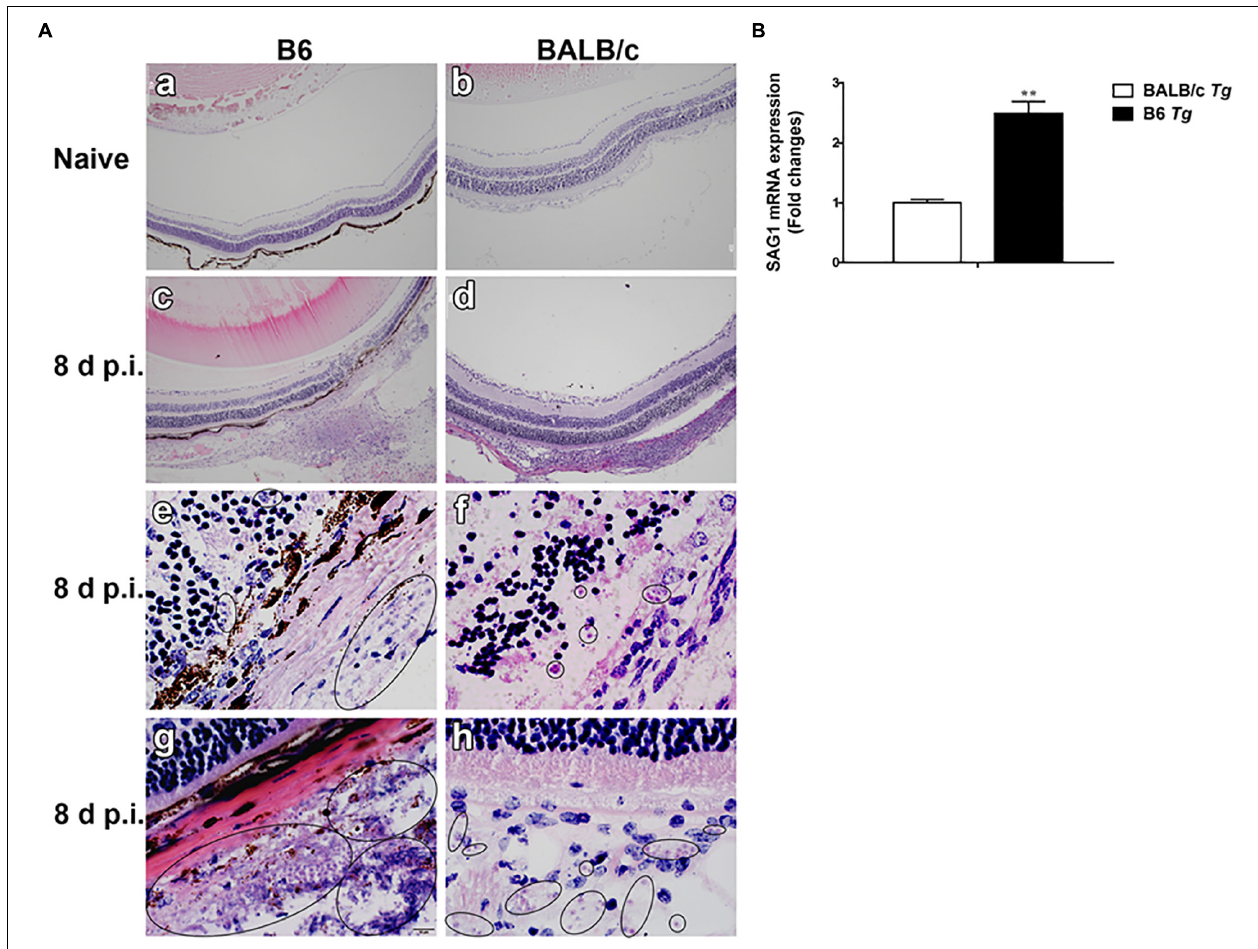
FIGURE 1 | Histological changes (A) and parasite burden (B) in the eyes of T. gondii -infected B6 and BALB/c mice. No histological change was observed in the eyes of uninfected B6 mouse (a) and BALB/c mouse (b) ; at day 8 p.i., severe damage was observed in the eye of T. gondii -infected B6 mouse (c,e,g) and moderate damage was observed in the eye of T. gondii -infected BALB/c mouse (d,f,h) . Black circle indicates the tachyzoites of T. gondii . The original magnification, a–d 100 × ; e–h 1000 × , H&E staining. The SAG1 mRNA expressions in the eyes were measured by using qRT-PCR. Data are presented as means ± SD; there were six mice in each group and the data shown are representative of those from two different experiments. ∗∗ P < 0.01, T. gondii -infected B6 mice vs. T. gondii -infected BALB/c